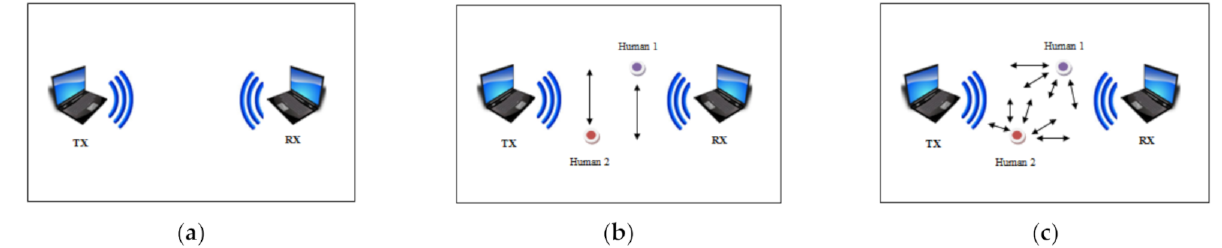
Figure 4. Link throughput measurements—experiment scenarios. ( a ) Scenario 1 (no-human); ( b ) Scenario 2 (fixed human); ( c ) Scenario 3 (random